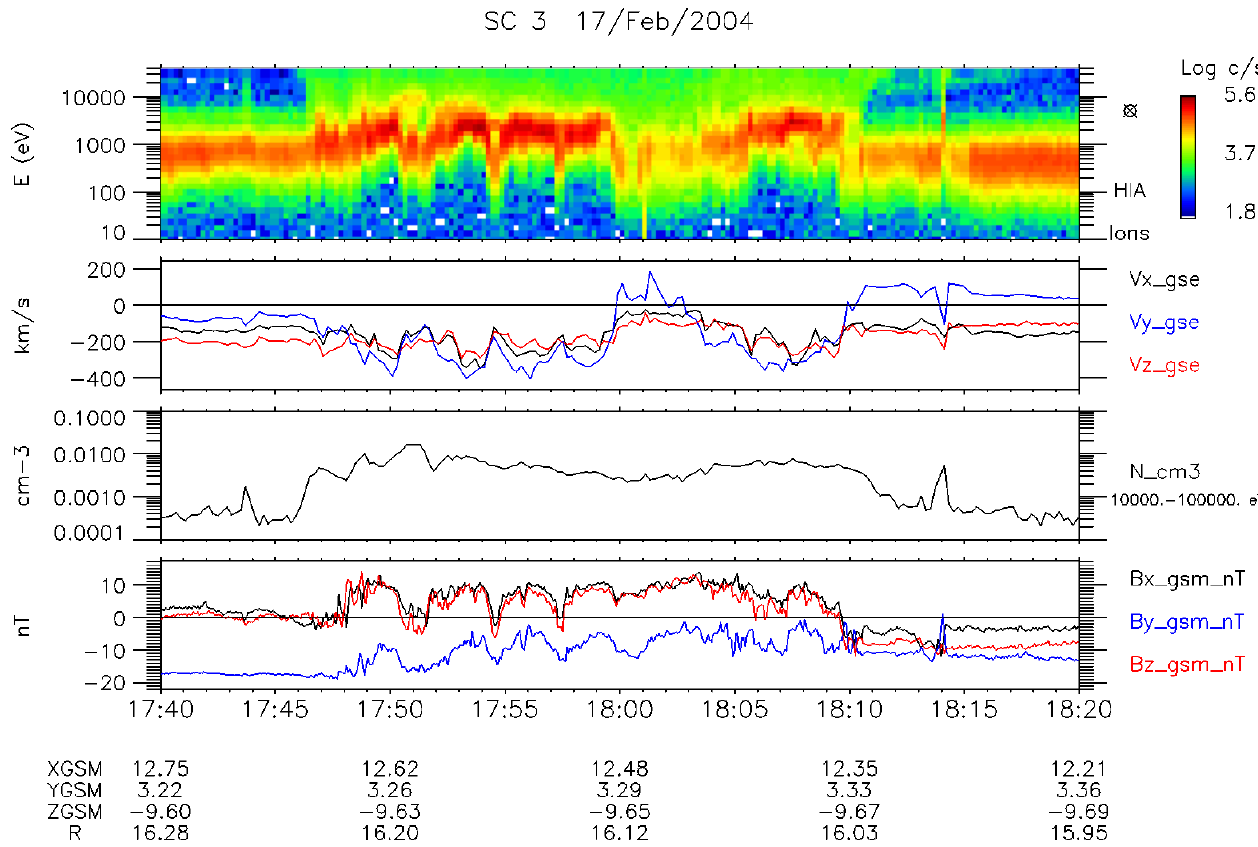
Fig. 2. Magnetic field and ion data from Cluster spacecraft 3 from 17:35UT to 18:30UT. From top to bottom: Energy-time spectrogram from HIA for all